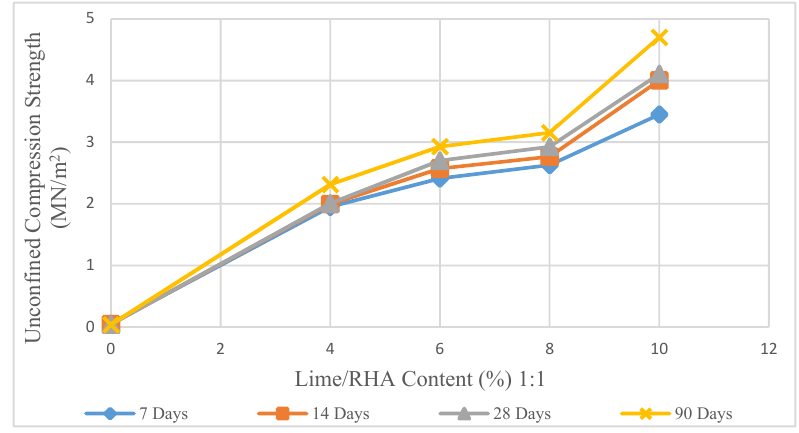
Figure 6. Effect of lime and rice husk ash (LRHA) content (1:1) on unconfined compression strength.